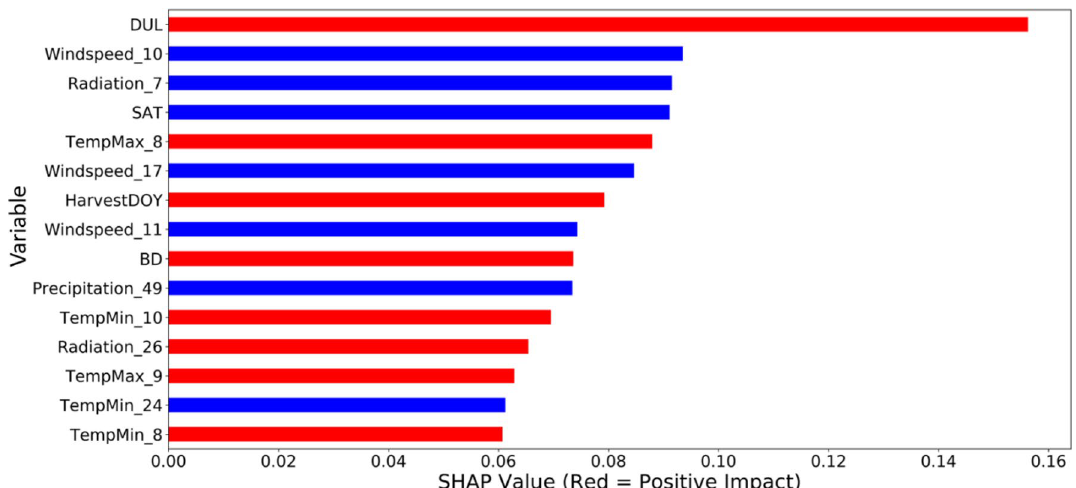
Figure 7. Shapley values for the top 15 features in winter wheat yield prediction in 2019 (For the weather variables on the vertical axis, the variable name refers to the title of the weather variable plus the week of the year the information was recorded, separated by an underscore sign) ( HarvestDOY Harvest day of the year, LL crop available water at permanent wilting point, SAT crop available water at the saturation point, DUL crop available water at the field capacity, BD soil bulk density).